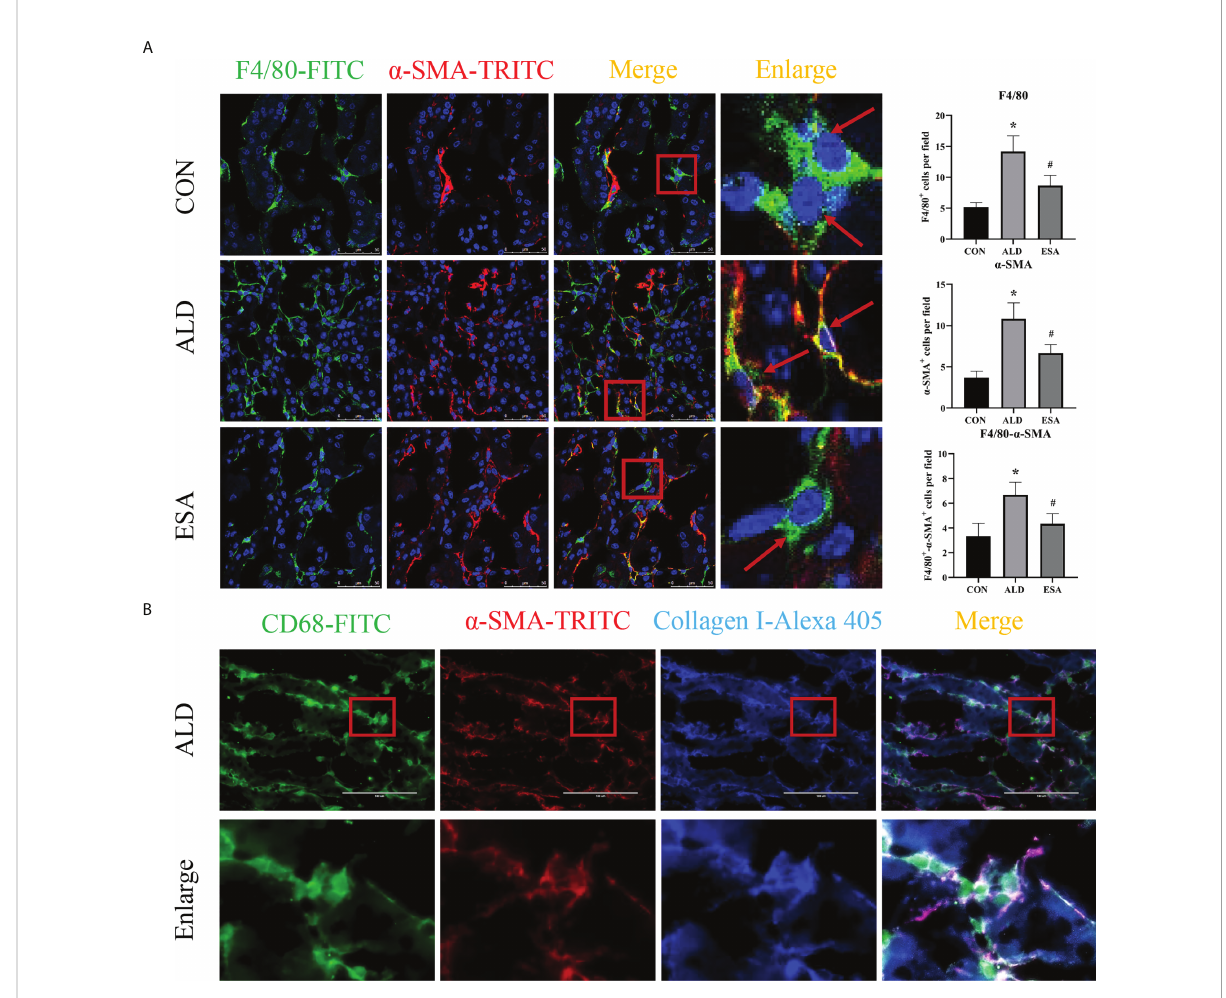
FIGURE 3 MMT in UNX+ALD-infused mice. (A) Immuno fl uorescence staining of kidney sections with antibodies against the macrophage marker F4/80 (FITC, green) and the myo fi broblast marker a -SMA (TRITC, red) to identify MMT (cells co-expressing both markers indicate MMT; nuclei were stained with DAPI in blue). (B) Immuno fl uorescence staining of kidney sections with antibodies against CD68 (green), a -SMA (red), and collagen I (blue). The data are presented as the mean ± SD (n = 6), *p < 0.05 vs. the CON group, # p < 0.05 vs. the ALD group. MMT, macrophage-to- myo fi broblast transition; UNX, uninephrectomy; ALD, aldosterone; FITC, fl uorescein